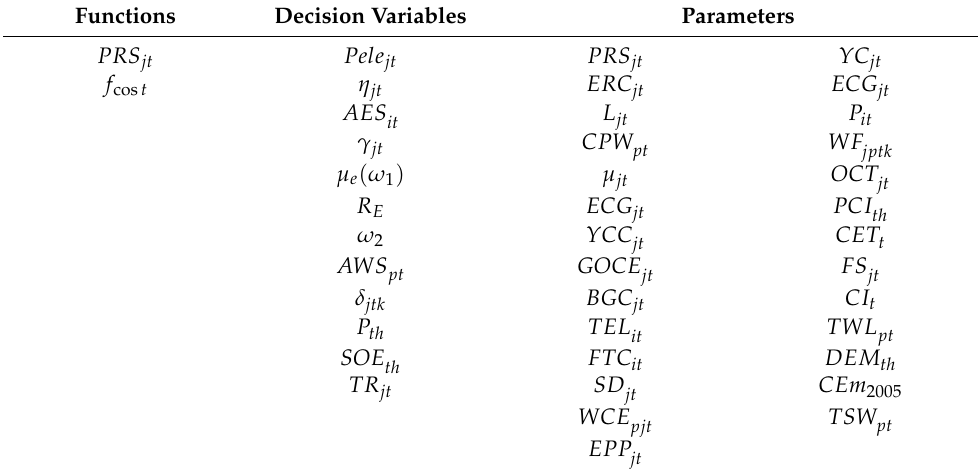
Table 1. The decision variables and parameters of the PCIO model.